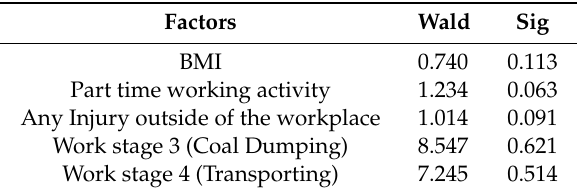
Table 3. The factors not significant for upper back